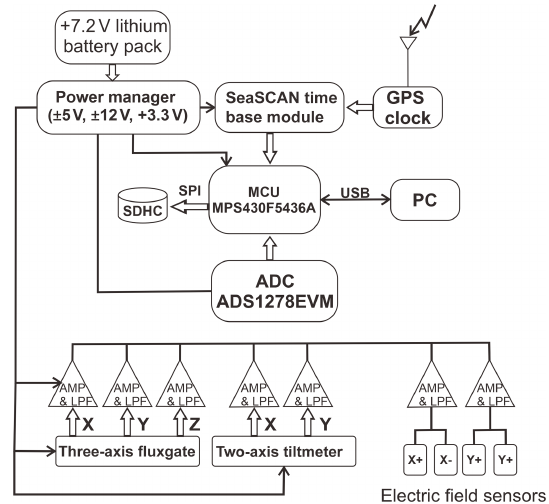
Figure 2. A block diagram of the OBEM data logger. The ADS1278EVM is a 24bit A/D with eight inputs used for converting analog signals via the amplifier and low-pass filter (Amp & LPF) to digital data. The Amp & LPF adjusts the output voltages of the sensors of the fluxgate, tiltmeter and electric receivers to suitable A/D input levels. The two MCUs of the MPS430F5436A process the timing synchronization by the SeaSCAN of time base and GPS modules, the digital data storage to the SD card with a standard SDHC, and the user interface communication with a